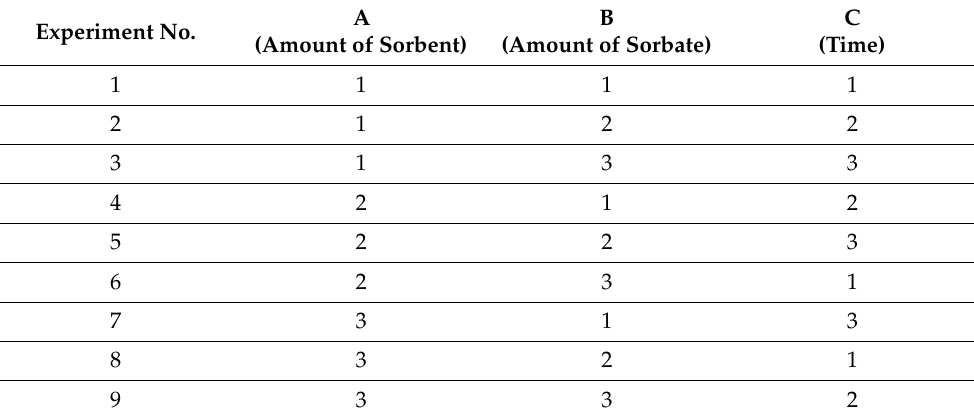
Table 7. Experimental design for biosorption of Pb as well as Cr on defatted seed residue of C. melo (by L9 orthogonal